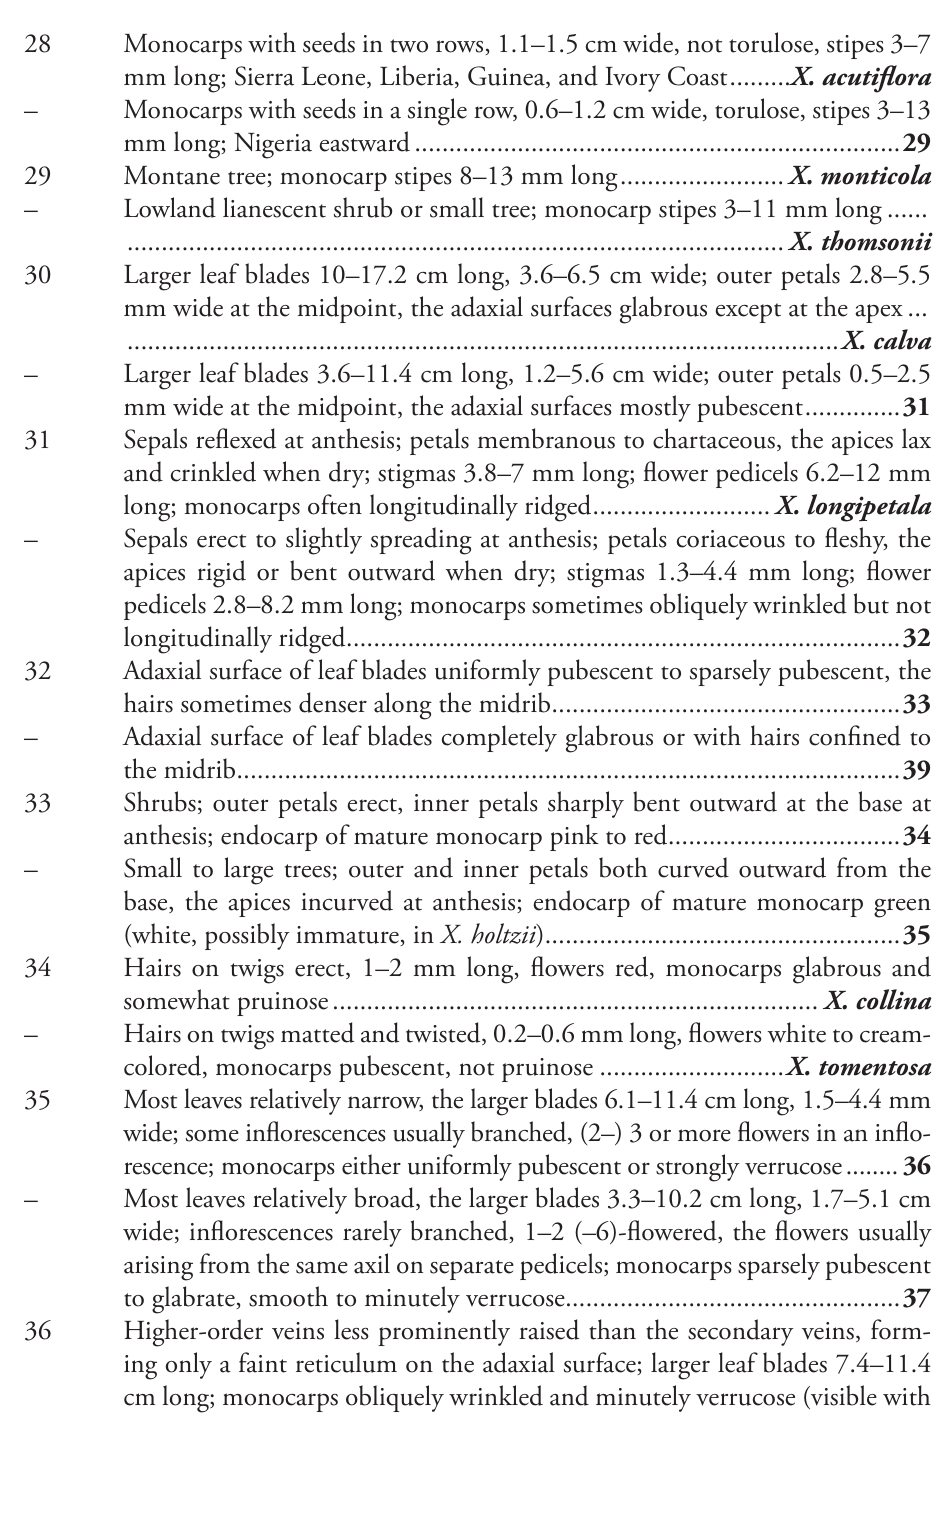
Monocarps with seeds in two rows, 1.1–1.5 cm wide, not torulose, stipes 3–7 mm long; Sierra Leone, Liberia, Guinea, and Ivory Coast ......... X. acutiflora mm long; Nigeria eastward ....................................................................... 29 Montane tree; monocarp stipes 8–13 mm long ........................ X. monticola